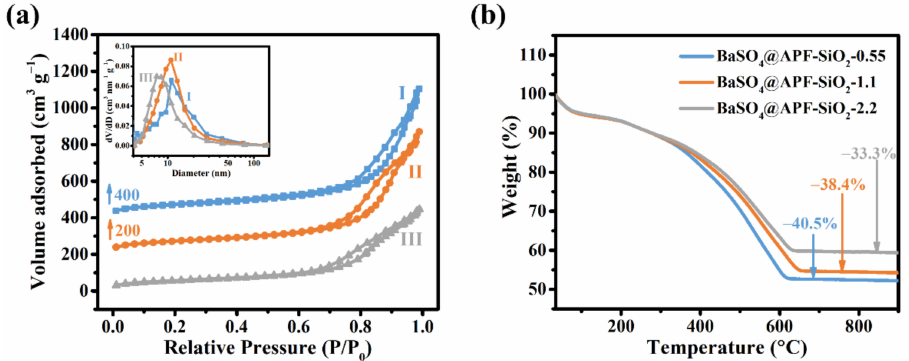
Figure 4. ( a ) N 2 sorption isotherms of (I) HMSN-0.55, (II) HMSN-1.1, and (III) HMSN-2.2; the inset is the Barrett–Joyner–Halenda (BJH) pore distributions derived from desorption branches, ( b ) Thermogravimetry (TG) curves of BaSO 4 @APF-SiO 2 prepared with TEOS additions of 0.545, 1.095, and 2.190 mL. Table 1. The shell thickness and texture properties of HMSNs and solid mesoporous silica nanoparticles (SMSN). Shell Thickness Sample